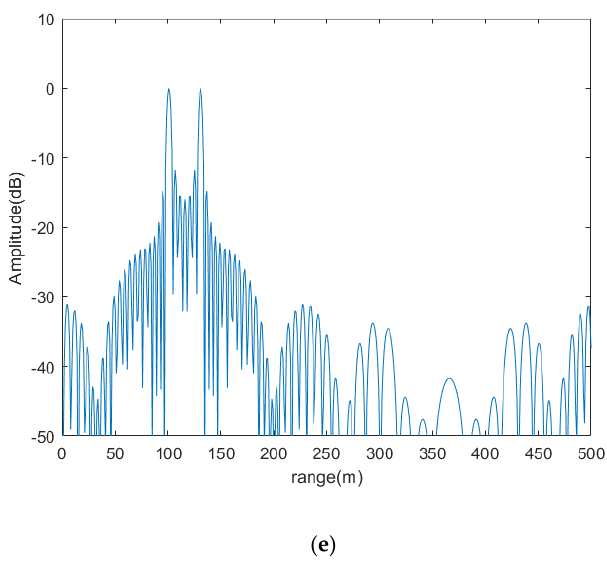
Figure 10. Simulation results. ( a ) echo of target 1. ( b ) demodulation results of target 1. ( c ). echo of target 2. ( d ) demodulation results of target 2. ( e ) demodulation results of mixed echo.